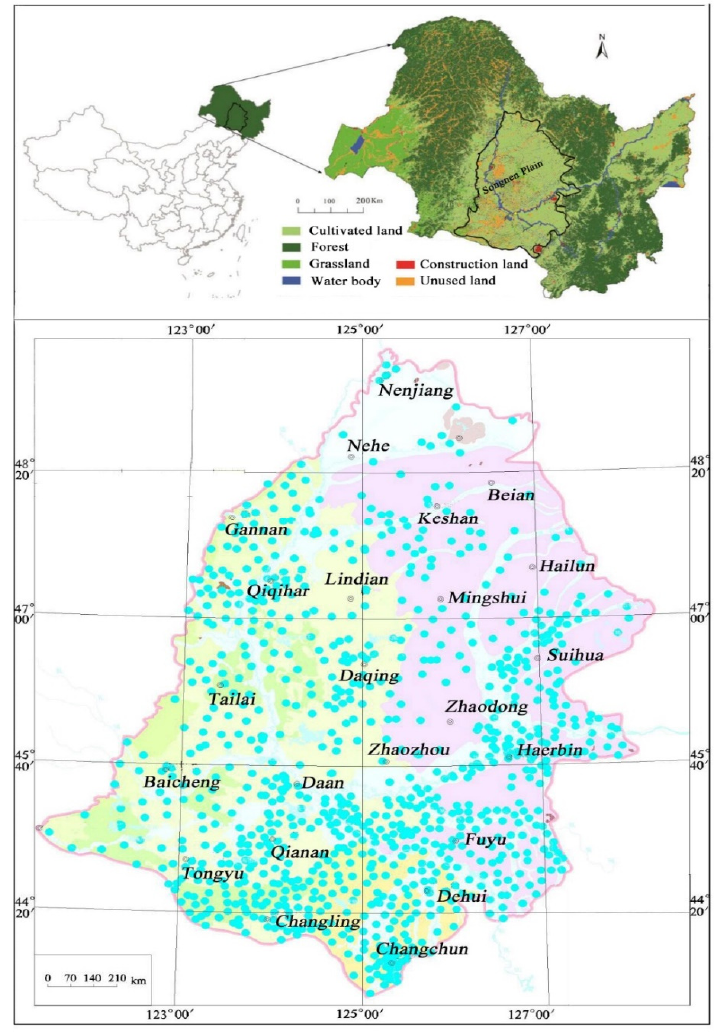
Figure 1. Location of sampling points in the study area.